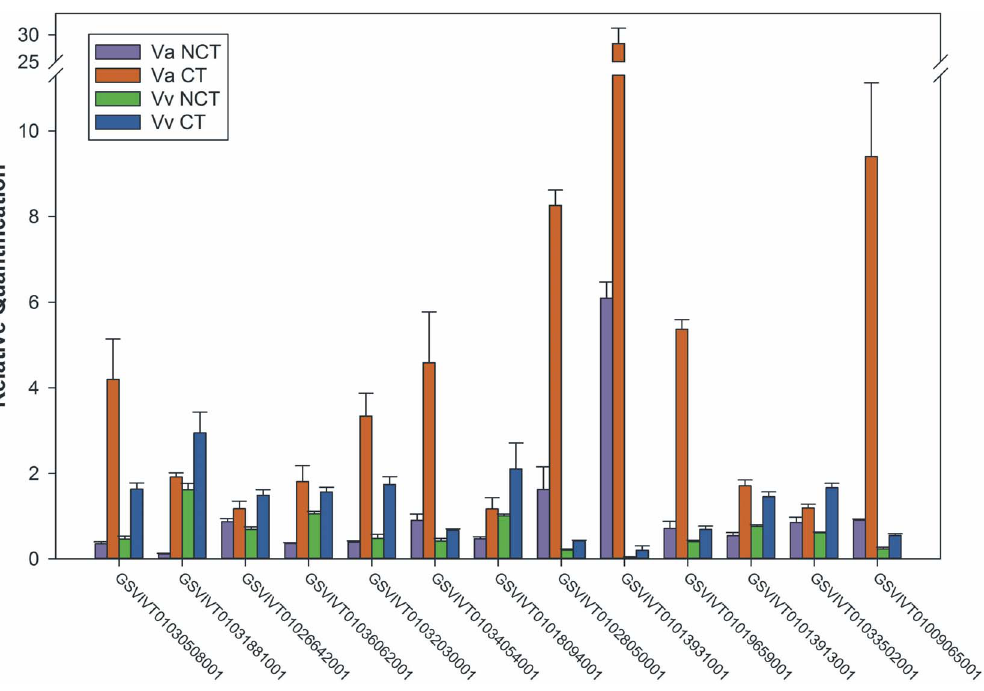
Figure 3. Real-time RT-PCR analysis for thirteen differentially expressed genes (DEGs) in V.amurensis and V.vinifera cv. Muscat of Hamburg. Real-time RT-PCR was carried out on three independent biological replicates each containing three technical replicates. The relative quantification of each transcript was normalized against UBC and GAPDH.